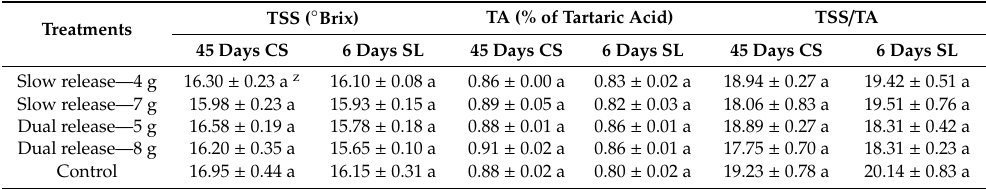
Table 4. Total soluble solids—TSS ( ◦ Brix), titratable acidity—TA (tartaric acid %) and their ratio (TSS / TA) of clamshell-packaged ‘BRS Nubia’ seeded grapes berries at 45 days of cold storage (CS) at 1 ± 1 ◦ C followed by 6 days of shelf life (SL) at 22 ± 1 ◦ C. TSS ( ◦ Brix) TA (% of Tartaric Acid) TSS / TA Treatments 45 Days